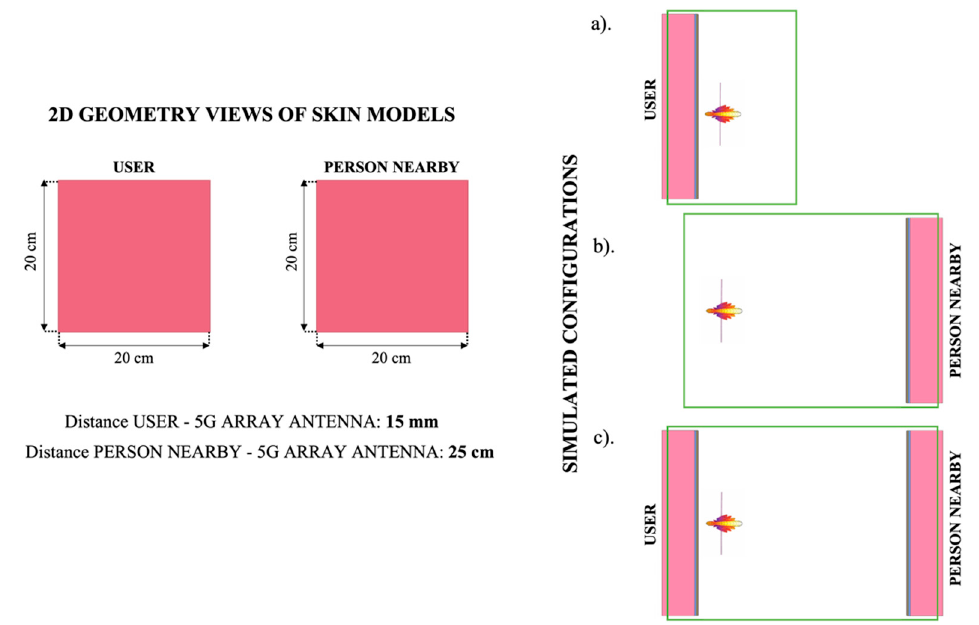
Figure 2. On the left, the 2D skin model geometry views of the mobile phone user and of a person who is passing nearby; the depth of the skin models is supposed as infinity, thanks to the position of the simulation boundary conditions (in green on the right). On the right, the three different configurations are shown with the simulation boundary conditions (in green), designed to investigate: ( a ) the exposure levels of the person using the mobile phone at a distance of 15 mm, alone; ( b ) the exposure levels of a person at a distance of 25 cm from the mobile phone (assuming that only the phone is present, while the mobile user is not present); ( c ) the exposure levels of both the user and a person in his proximity, when they are simultaneously present.